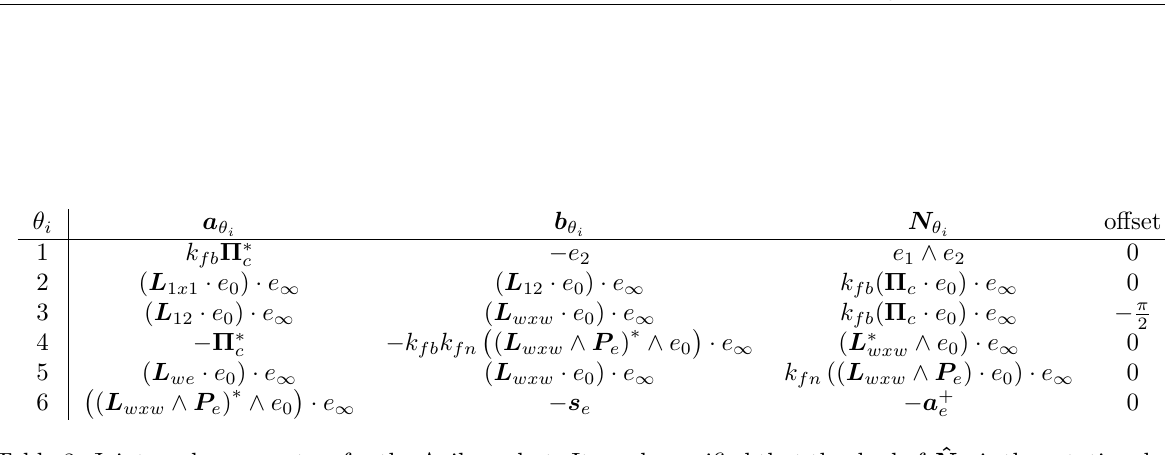
Table 3: Joint angle parameters for the Agilus robot. It can be verified that the dual of ˆ N θ z i − 1 of the Denavit-Hartenberg convention. Note that the table shows the non-normalized bivectors N θ . i